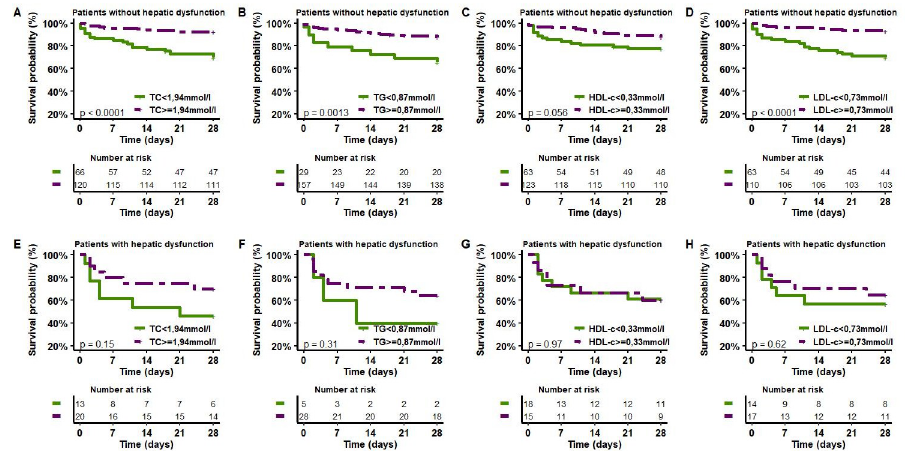
Fig 4. Kaplan–Meier estimates of survival in the 28 days after the onset of sepsis for patients with different initial levels of lipoproteins, according to hepatic dysfunction status. TC: total cholesterol, HDL-C: high-density lipoprotein-cholesterol, LDL: low-density lipoprotein-cholesterol, TG: triglycerides.